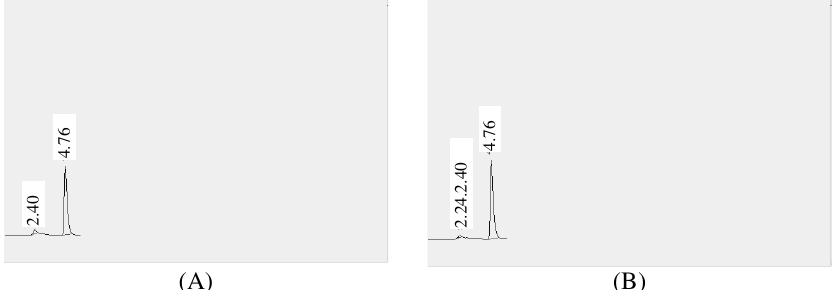
Figure 3 (A). Chromatograms of esmolol hydrochloride standard solution (10 µ g/mL) and (B) Esmolol hydrochloride in pharmaceutical dosage